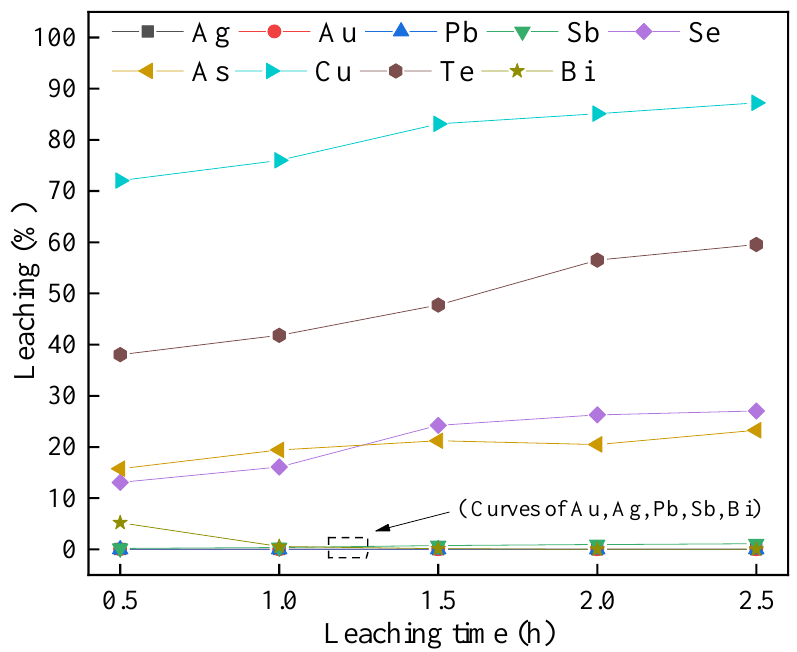
0 . 5 Figure 3. Effect of time on the leaching of each element (T = 150 ◦ C, P = 0.8 MPa, H 2 SO 4 = 100 Figure 3. Effect of time on the leaching of each element (T = 150 °C, P = 0.8 MPa, H 2 SO 4 = 100 g/L).